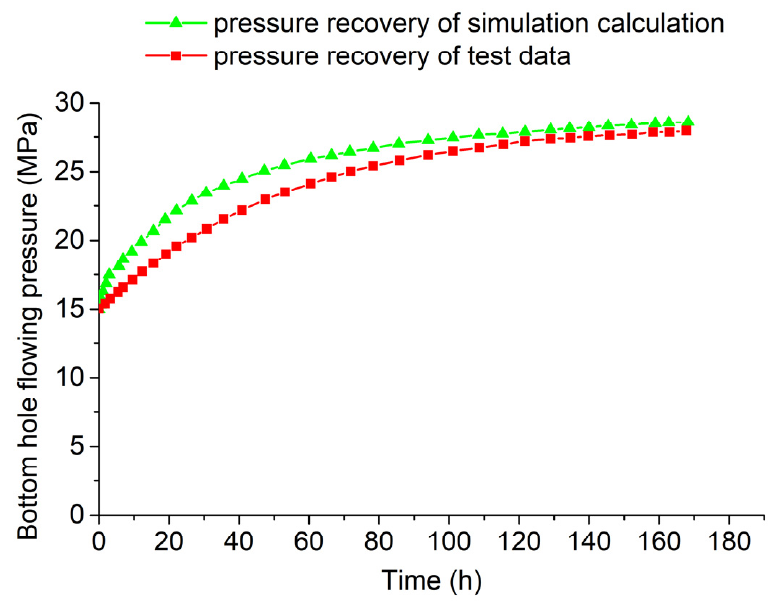
Figure 9. Comparison of pressure recovery simulation calculation results and test data. Table 9. Basic parameters of oil reservoir and horizontal well A. Table 10. Error analysis of the results of pressure recovery simulation calculation and test data. Well Parameters \ Well Number